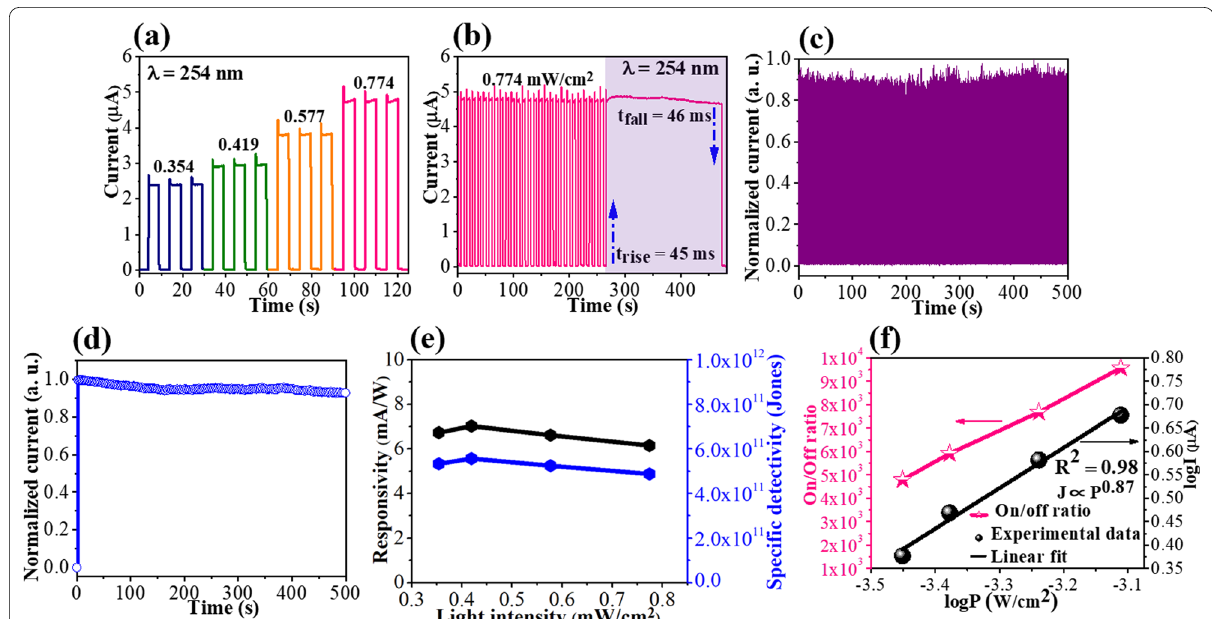
Fig. 4 a Photoresponses of the detector with different incident light intensities from 0.354 to 0.774 mW/cm 2 under bending test; b Transient photoresponse and stability of the detector under repeated on/off mode; c I-t curve with 500 on/off cycles; d Current with long-time UV exposure; e Responsivity and specific detectivity as a function of the power light; and f The logarithm of generated current under 254-nm irradiation and on/ off ratio as a function of light